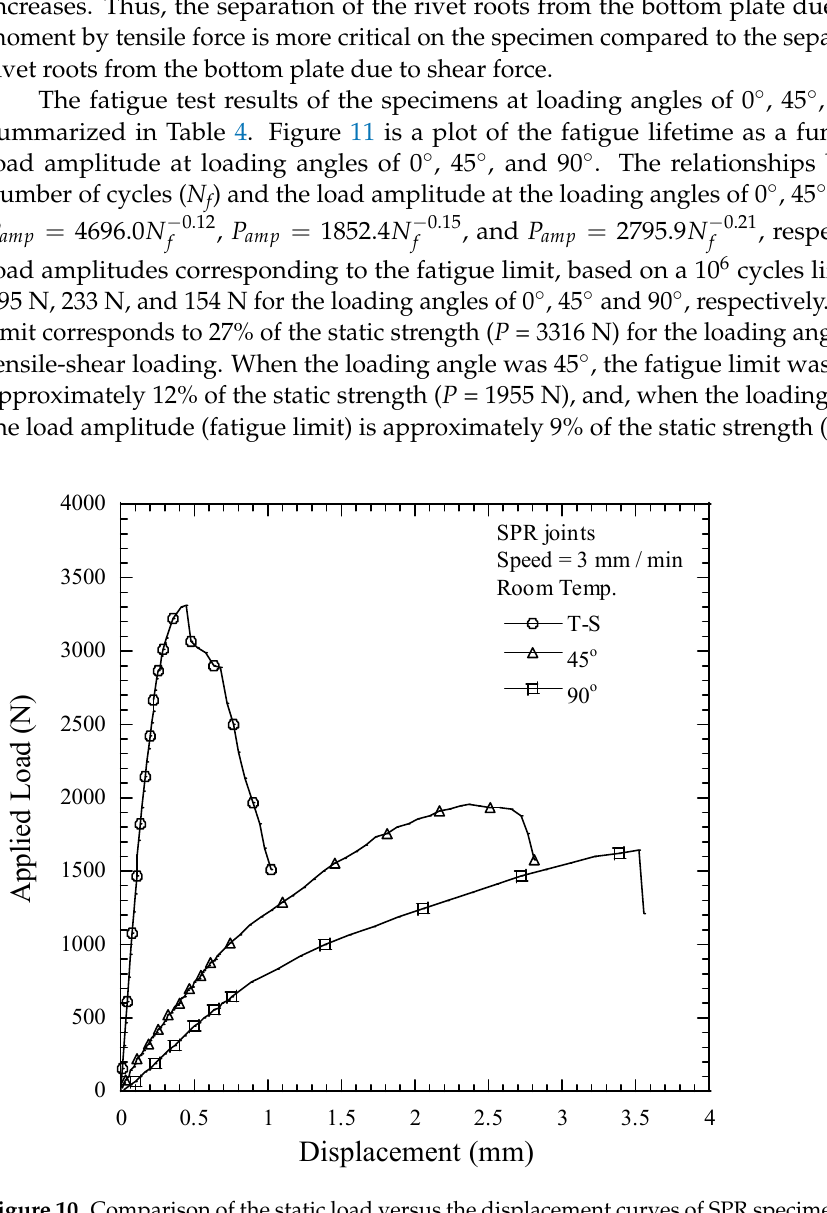
Figure 10. Comparison of the static load versus the displacement curves of SPR specimens at different loading angles.